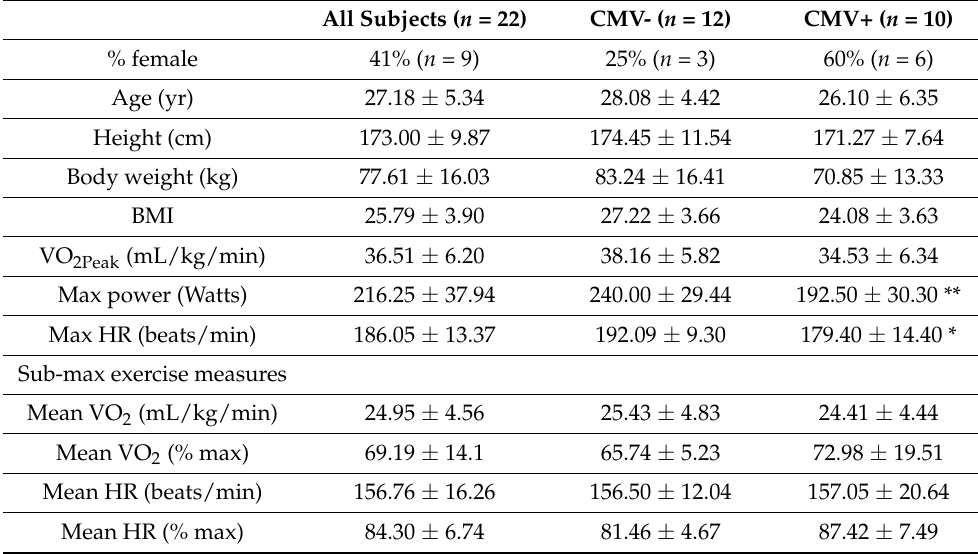
Table 2. Physical characteristics and exercise performance of the participants ( n =